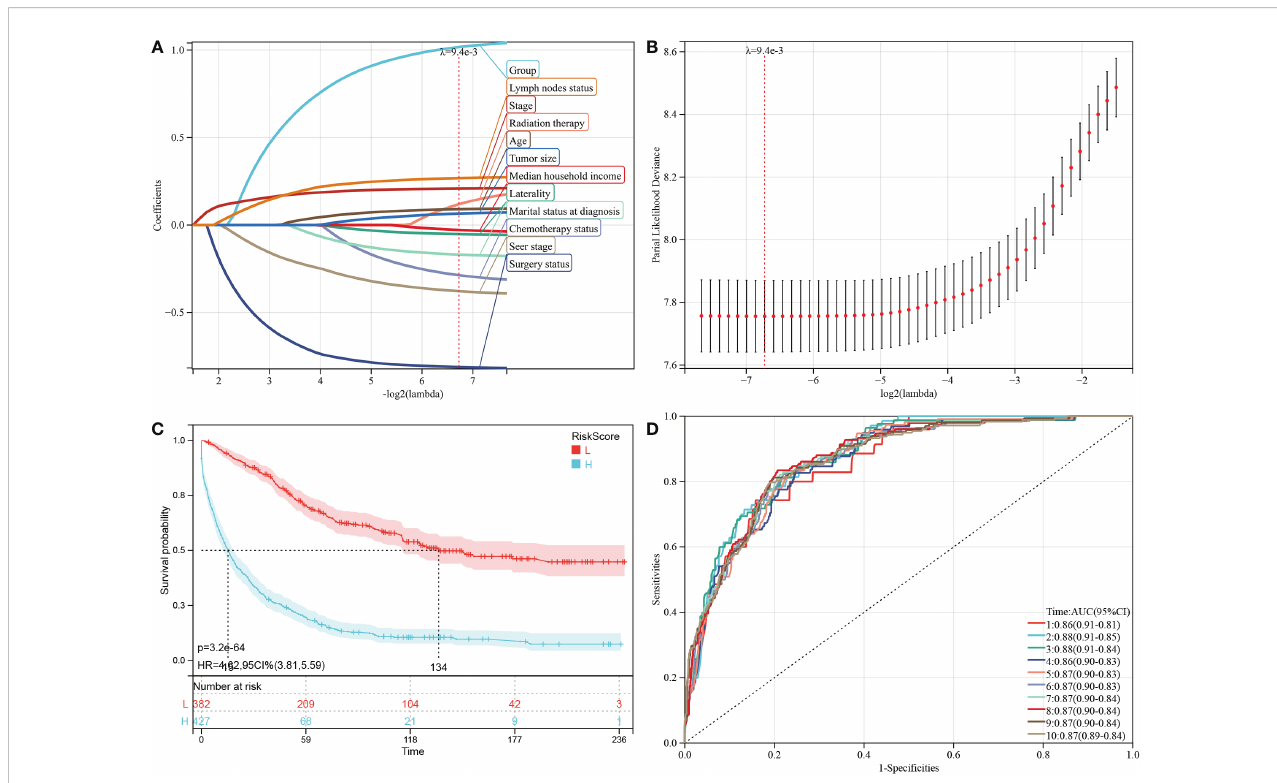
FIGURE 4 Construction and evaluation of OS associated predictive models. (A, B) The LASSO coef fi cient pro fi les and LASSO deviance pro fi les, respectively, show the optimal l value and risk factors. (C) KM survival curves of OS according to the risk score perform that prognosis of low-risk group is signi fi cantly better than high-risk score group. (D) ROC curves of OS at 1-10 years according to the risk score in the predictive model data